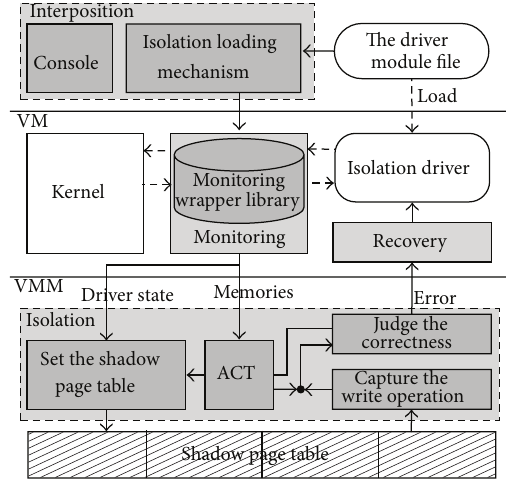
Figure 1: The architecture of